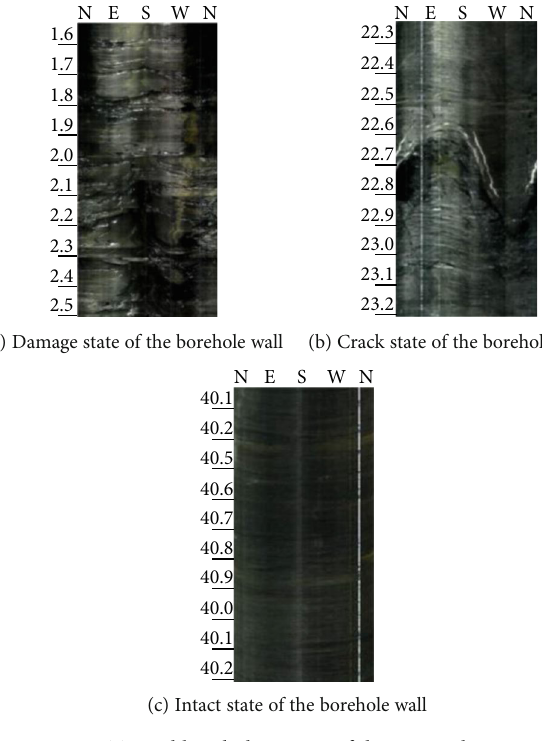
Figure 3: Typical borehole images of the top-coal structure.